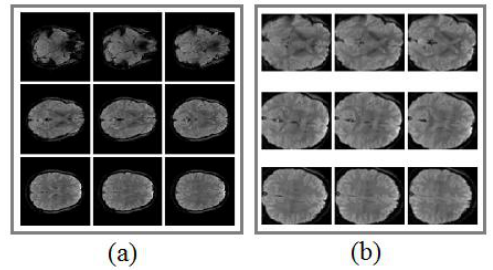
Figure 2. Preprocessing using SPM8: (a) original fMRI scan, (b) preprocessed data.